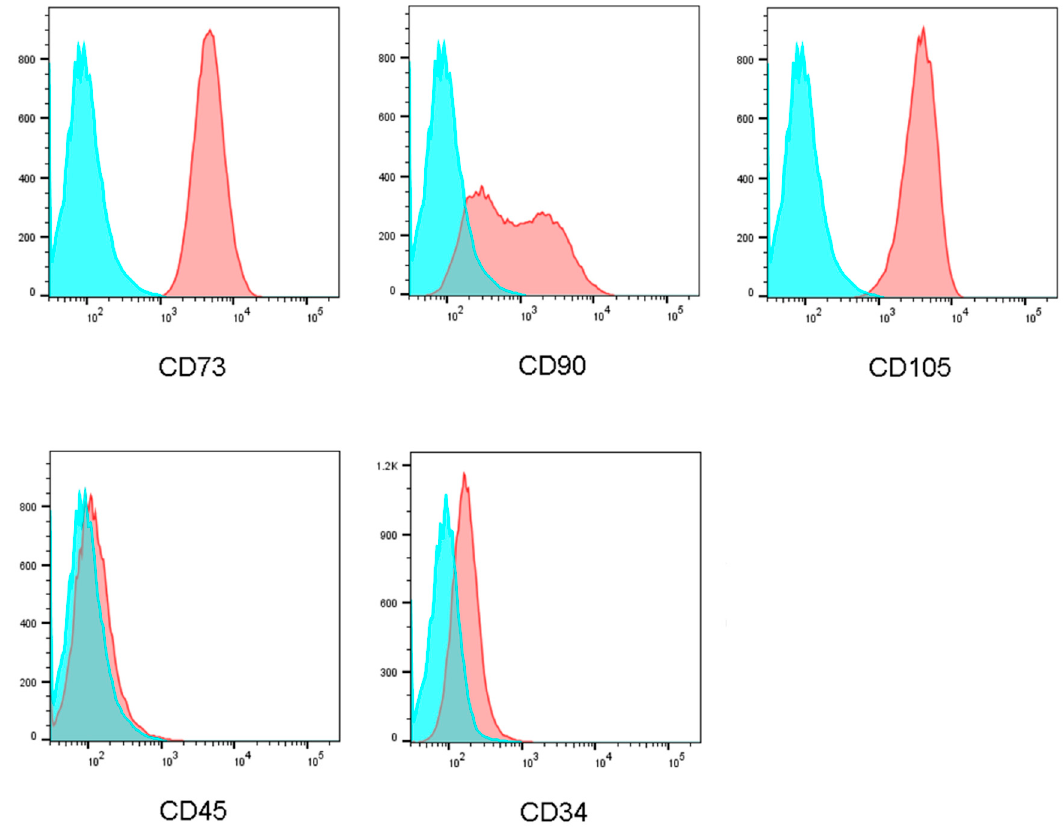
Figure 8. Flow cytometry assay of the WJ-MSCs. The cells expressed CD 73, CD 90, and CD 105, which are surface markers representing mesenchymal stem cells.